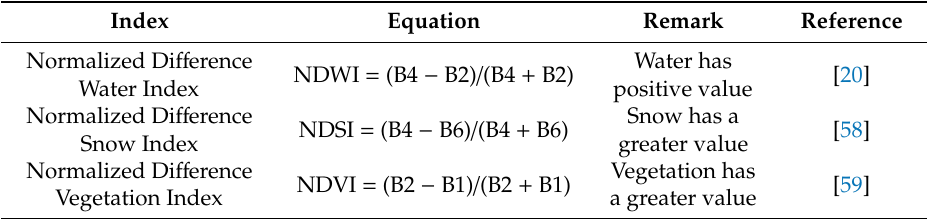
Table 2. Satellite-derived indexes used for endmember selection (Bi is the ith band of MOD09A1).